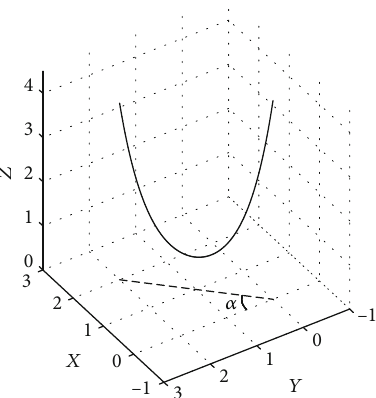
= y = 2 and z dist dist dist